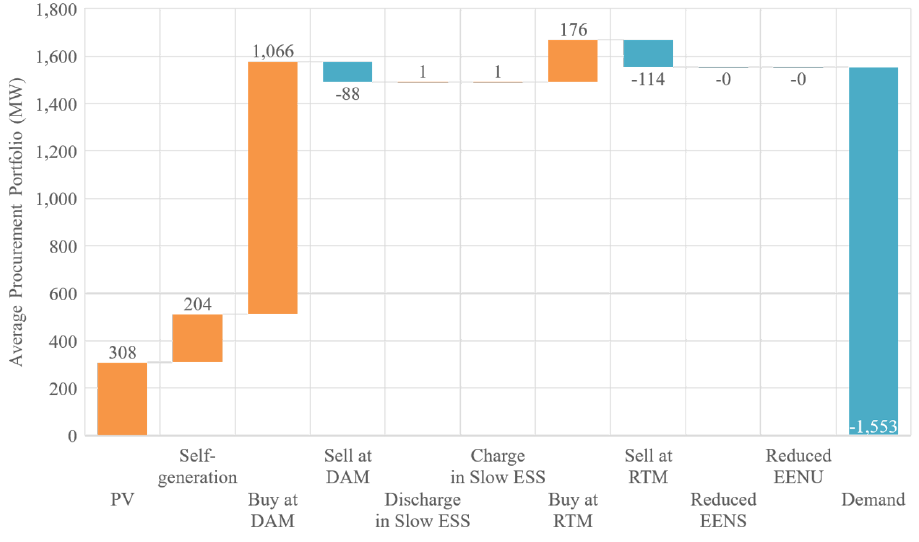
Figure 6. Average power procurement portfolio.